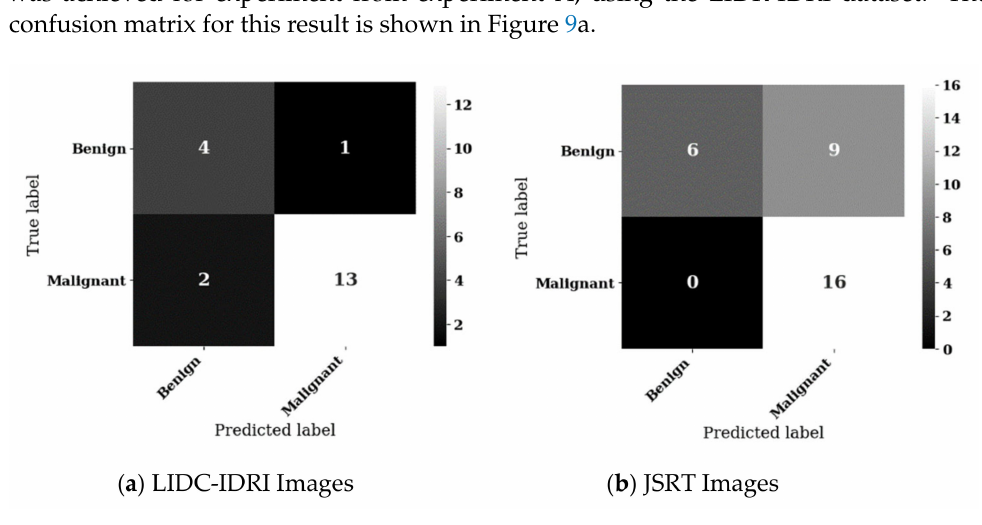
Figure 9. Confusion matrices for best results from LIDC-IDRI and JSRT inferencing datasets analysed